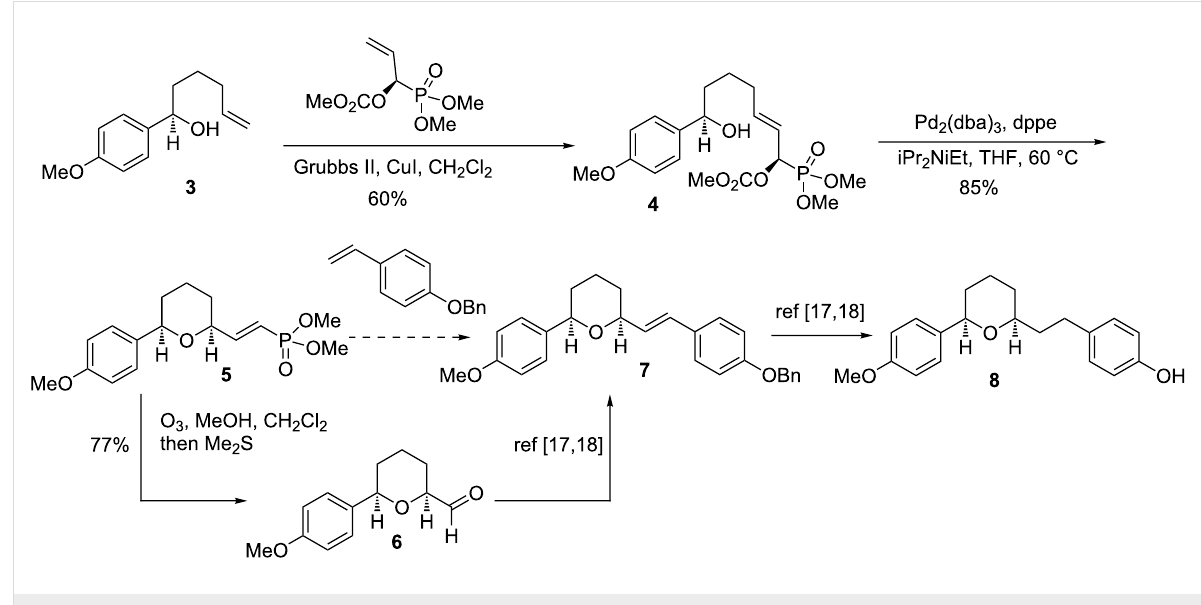
tuted vinylphosphonates are unreactive towards cross metathesis and are therefore type IV substrates. Since alkene cross metathesis is a powerful method of combing organic frag- ments in natural product synthesis, the value of vinylphospho- nates as synthetic intermediates would increase if their reactiv- ity could be enhanced to a level where they would participate in cross metathesis